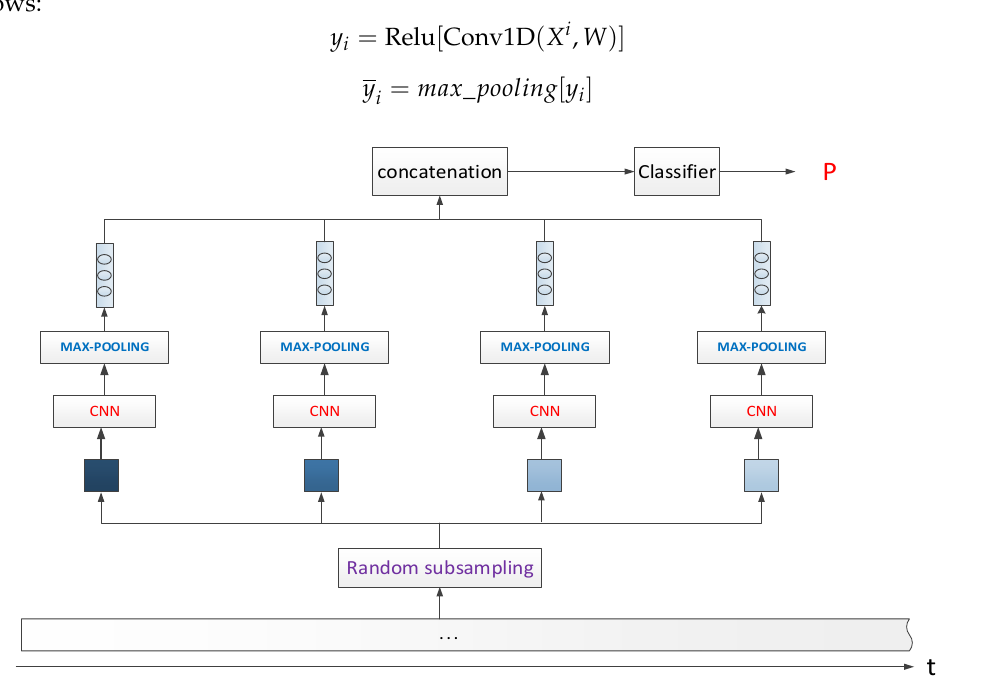
Figure 1. Model convolutional neural networks (CNN)_Random_Agg architecture.